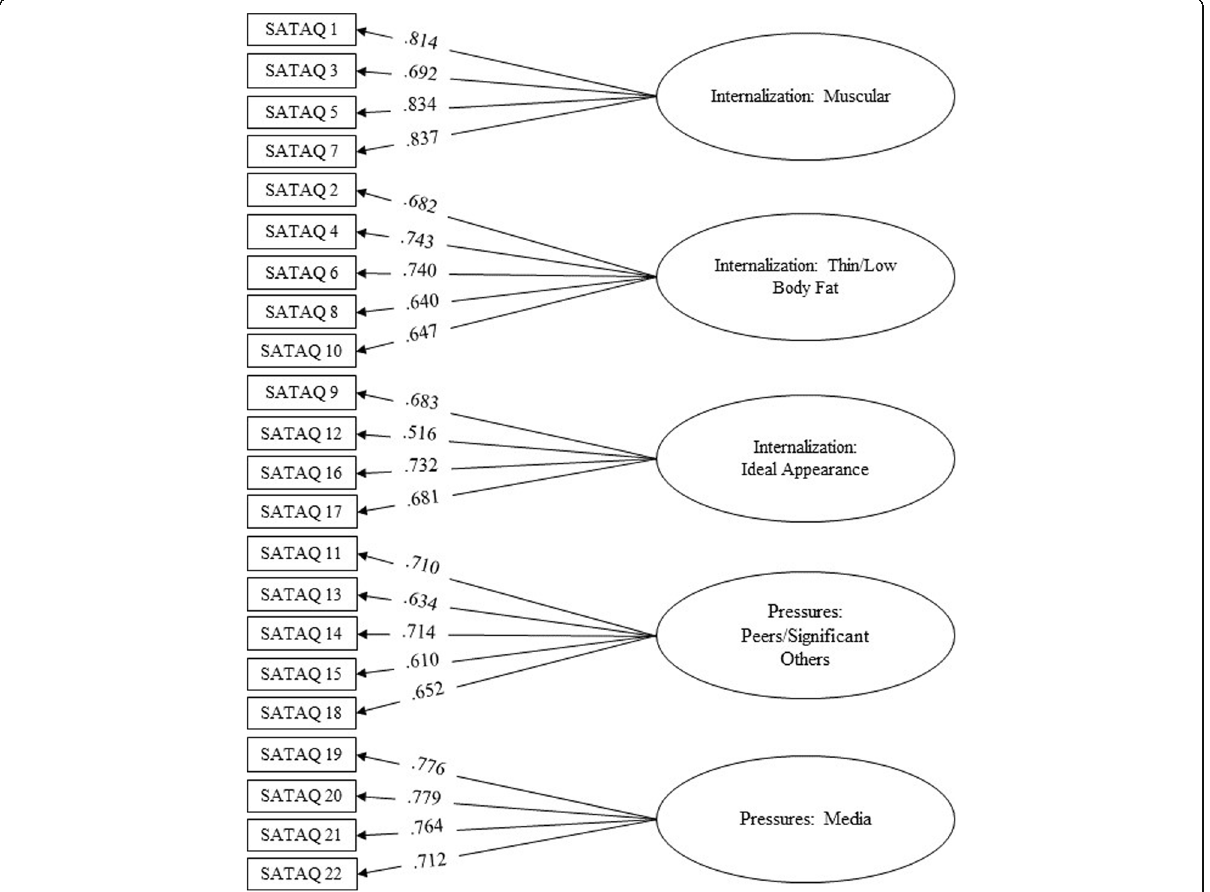
Fig. 1 Factor structure of the SATAQ-4R for Brazilian